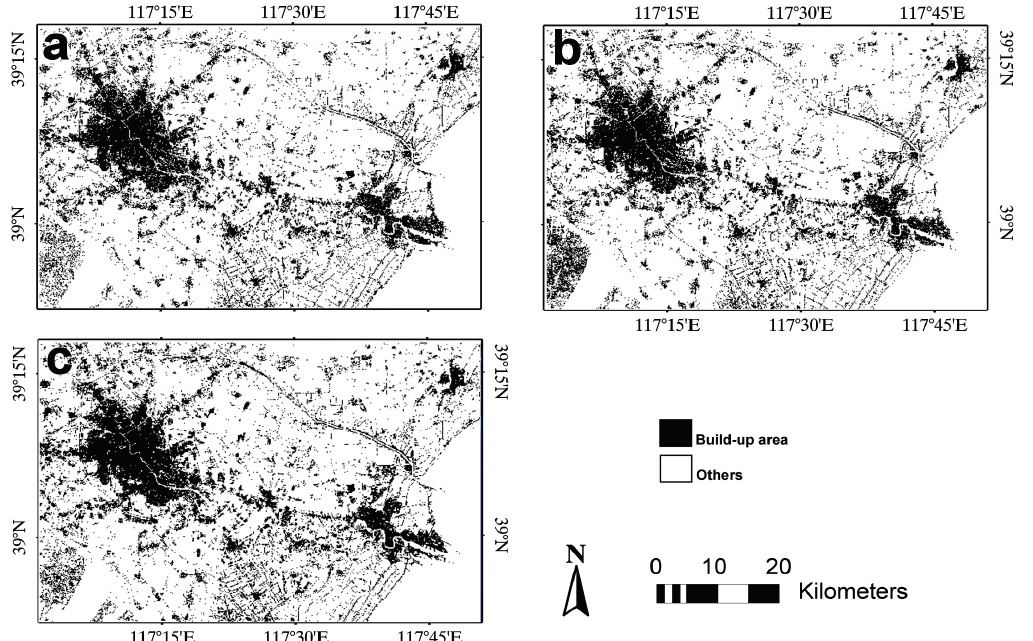
Figure 7. Classification results of the 1992 Tianjin image using spectral information alone ( a ); using spectral information and one-band texture ( b ); using spectral information and multivariate variogram texture with spectral angle distance ( c